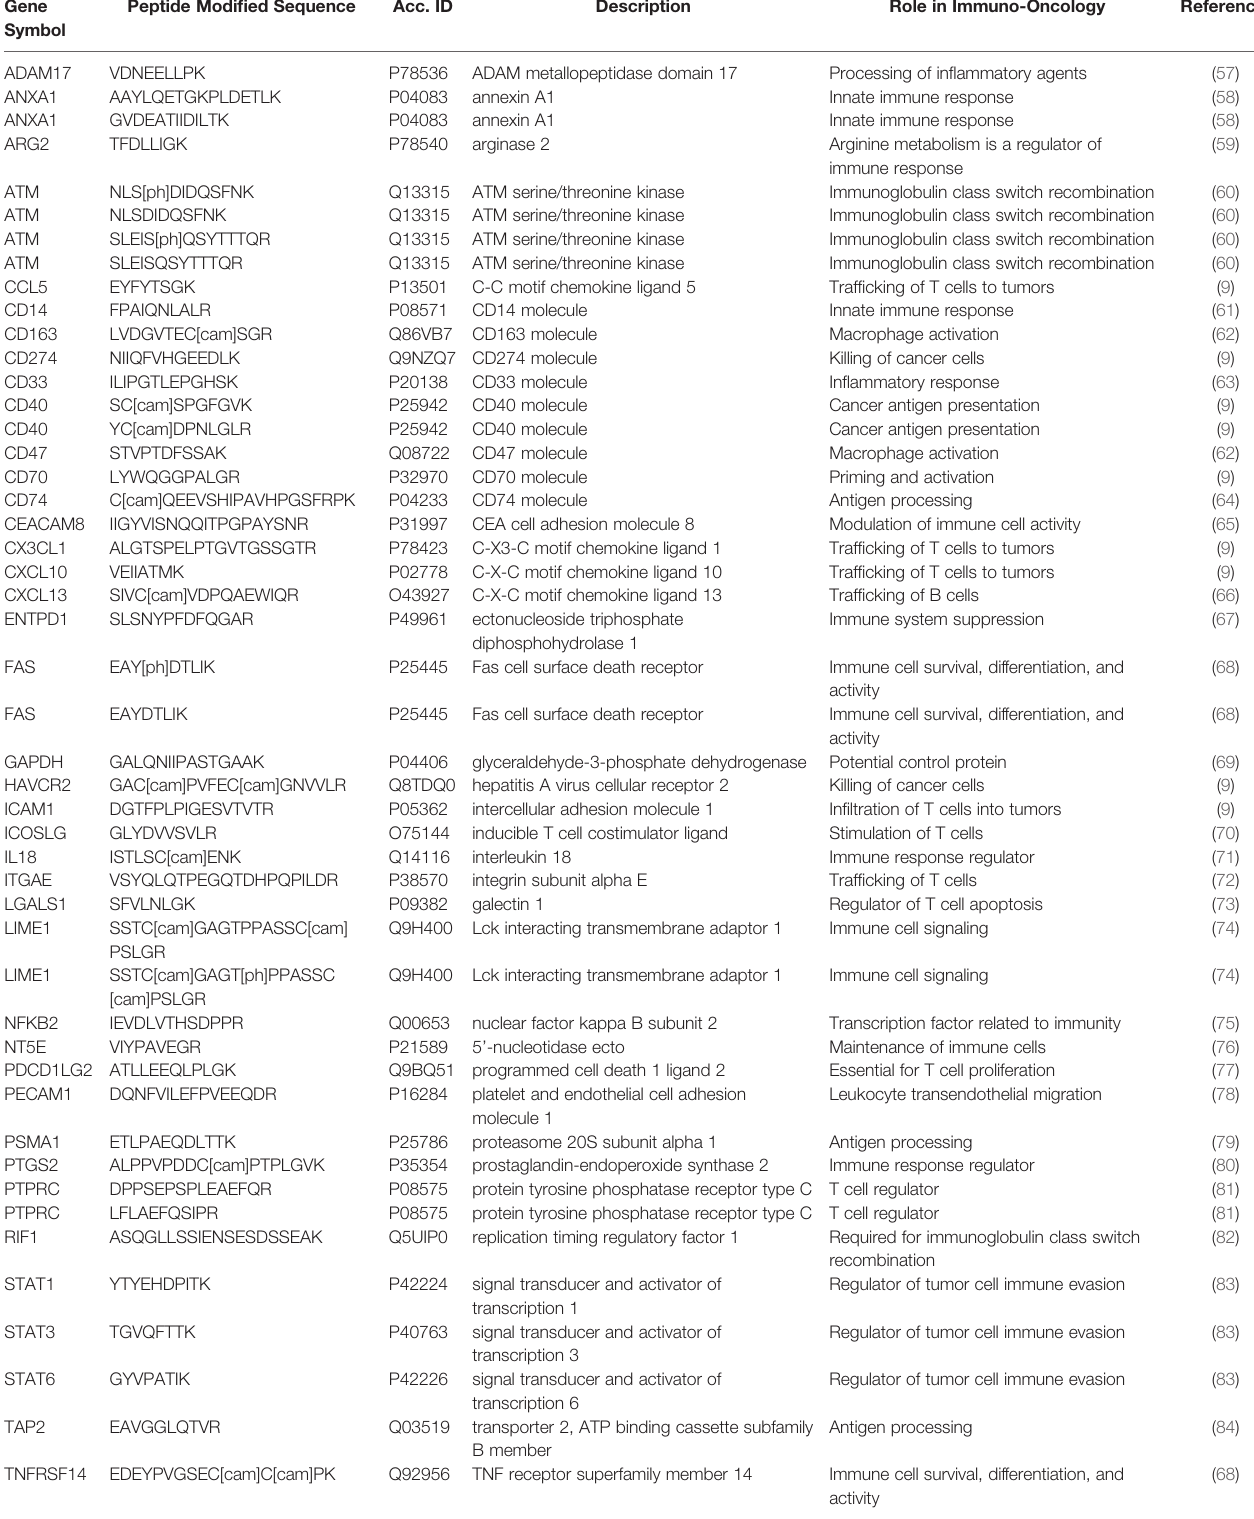
TABLE 1 | Peptides targeted for the multiplexed IO-1 immuno-MRM assay panel. Gene Peptide Modi fi ed Symbol